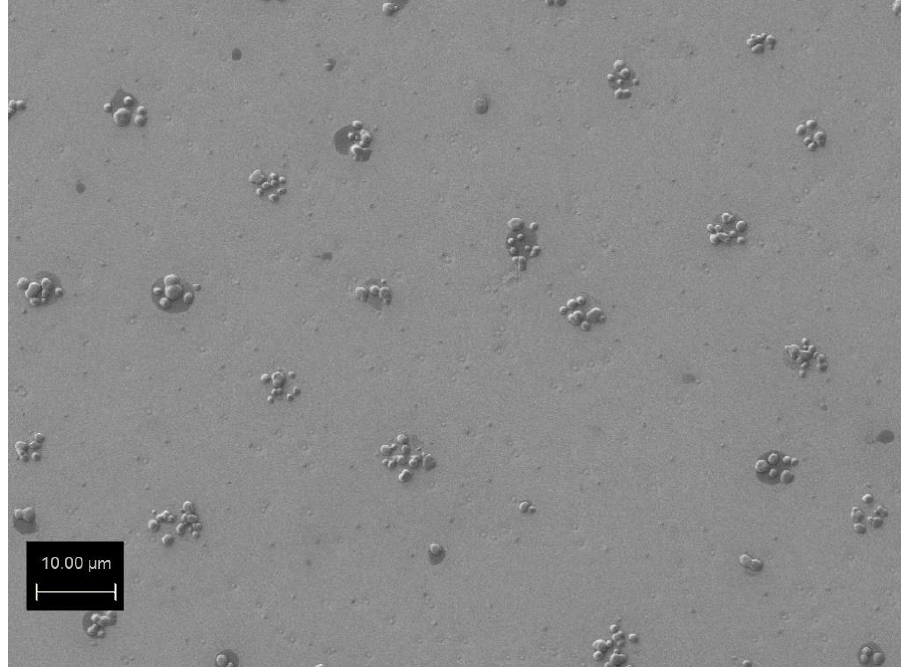
Figure 1. SEM image of the surface of the Gr/Ge(001)/Si(001) after 3 h of water vapor treatment.